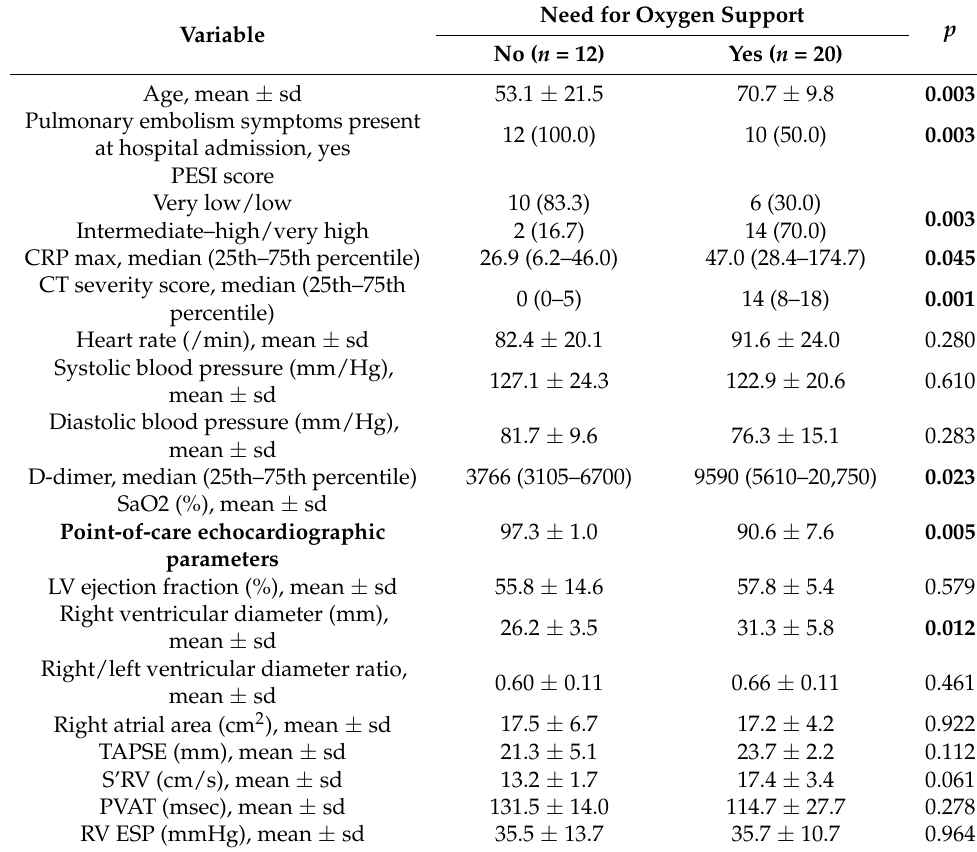
Table 6. Need for oxygen support according to characteristics of patients, clinical parameters, laboratory parameters, vital parameters at the time of pulmonary embolism diagnosis, and point-of- care echocardiographic parameters of the study